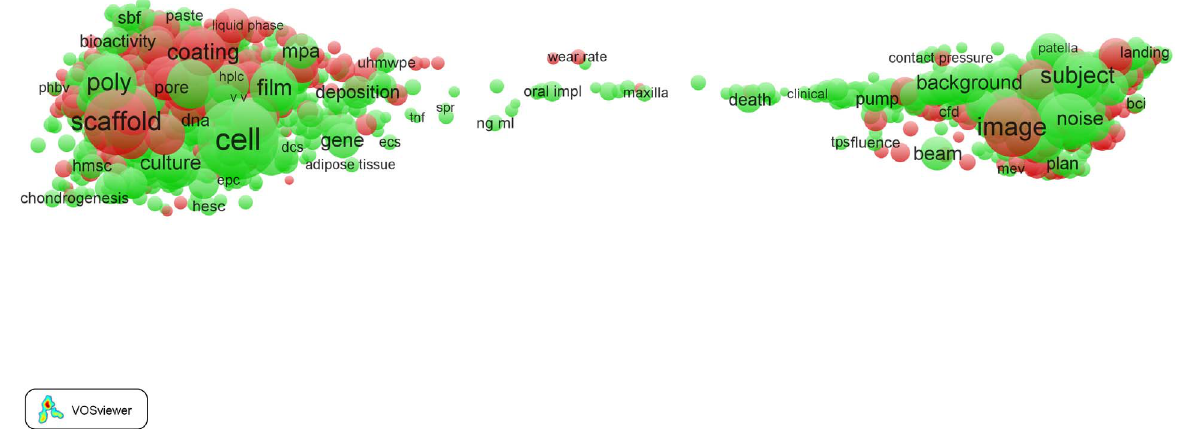
Figure 9. Term map of the Biomedicalengineering field.